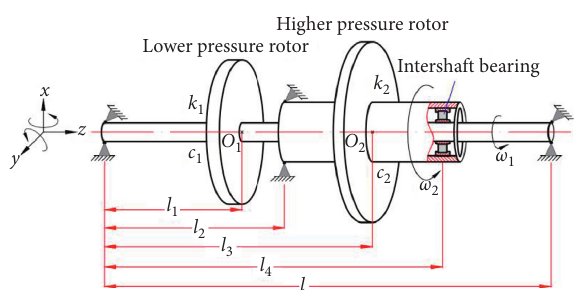
Figure 1: A simple two-disk dual-rotor system supported by four points with an intershaft